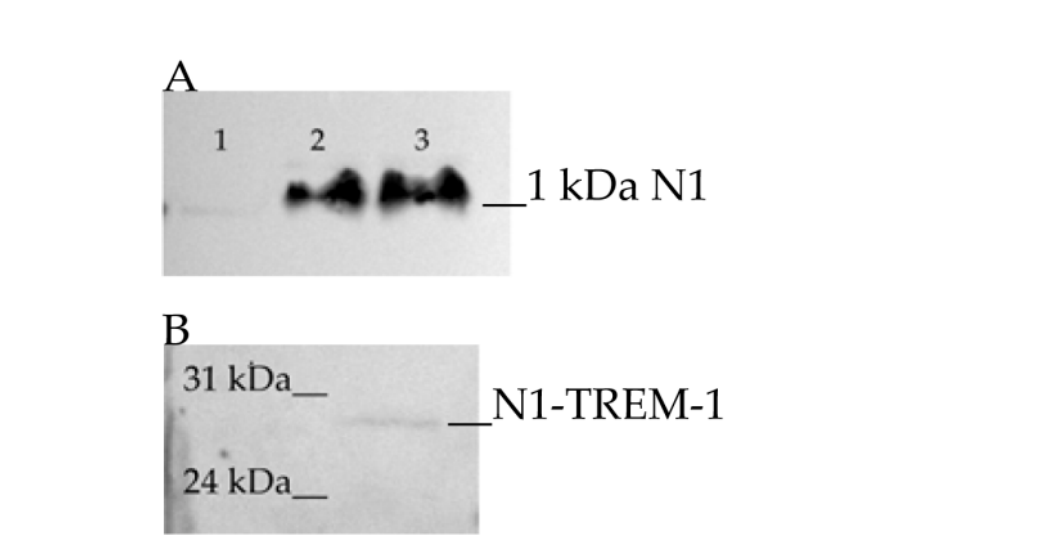
Figure 2. Binding of N1 with sTREM-1. ( A ) Binding of biotin-N1 with sTREM-1, immobilized on CNBr-activated Sepharose; 1—washing before elution, 2—elution of N1 peptide, 3—control N1 peptide. The resulting material was analyzed with tricine–SDS-PAGE followed by streptavidin–HRP Western blotting. ( B ) Binding of biotin-N1 with sTREM-1 on monocytes. Monocytes incubated with biotin-N1 and treated with crosslinker BS 3 . Cells lysed and purified with Dynabeads, conjugated with anti-TREM-1 antibodies. The resulting material was analyzed by SDS electrophoresis followed by streptavidin–HRP Western blotting.